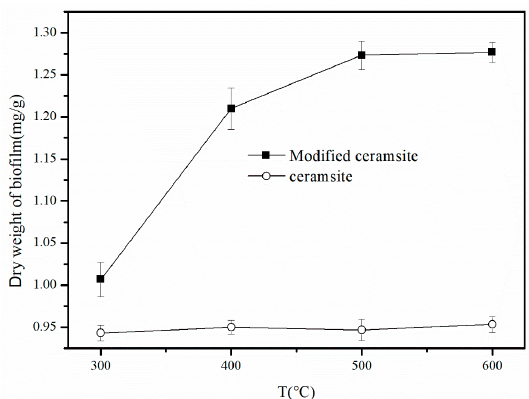
Figure 2. Dry weight of biofilm under different calcination temperature (300, 400, 500 and 600 °C) of the modified ceramsite.